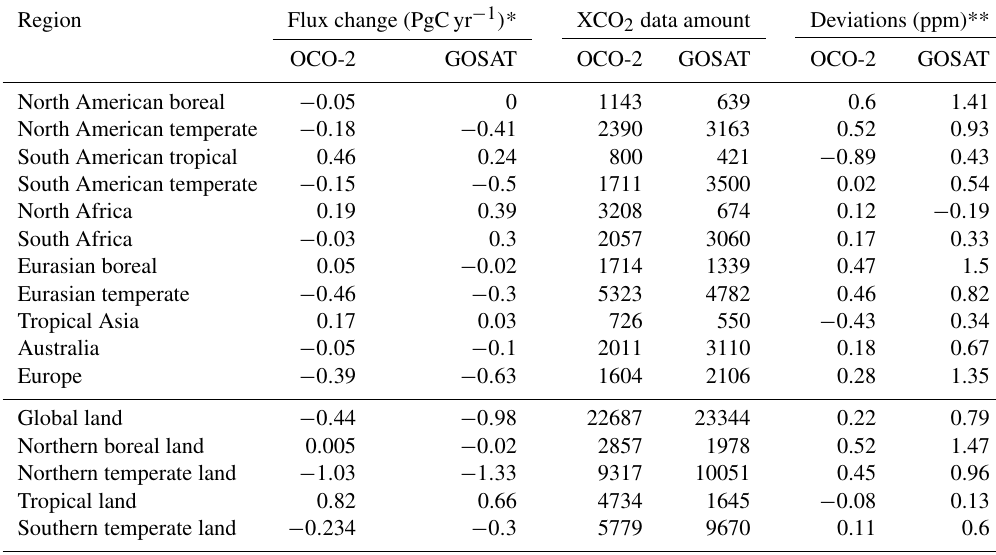
Table 4. Differences between the inferred and the prior carbon fluxes, the data amount of XCO 2 , and the deviations between the XCO 2 modeled with prior flux and satellite-retrieved XCO 2 in different regions.